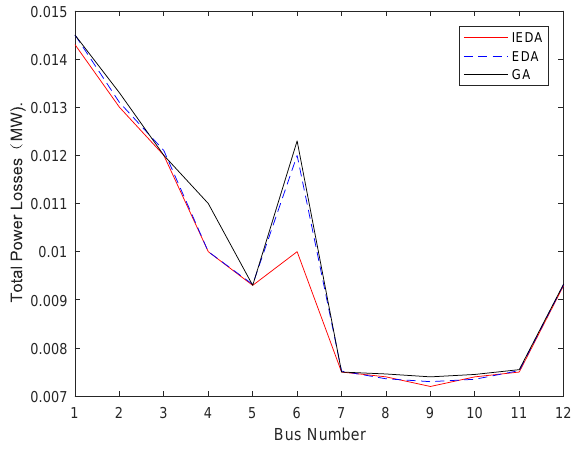
Figure 6. Distribution of network loss of each bus in the 12 bus radial distribution